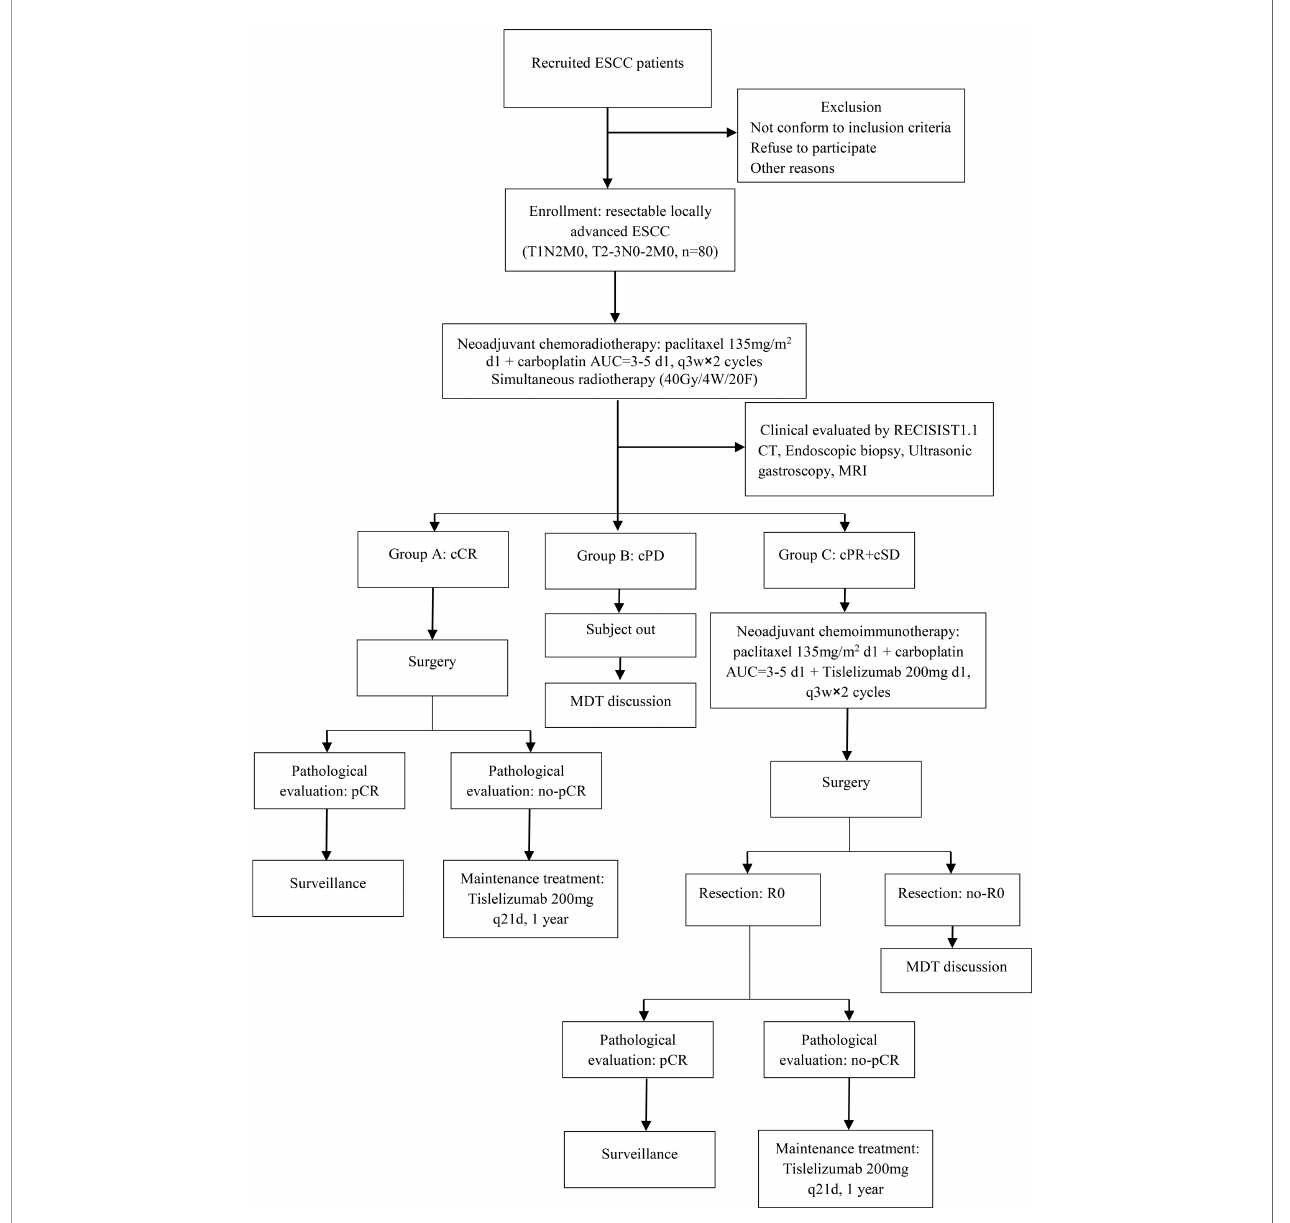
FIGURE 1 | Flowchart of the exploratory study. ESCC, esophageal squamous cell carcinoma; cCR, clinical complete response; cPD, clinical progressive disease; cPR, clinical partial response; cSD, clinical stable disease; MDT, multidisciplinary team; pCR, pathology complete